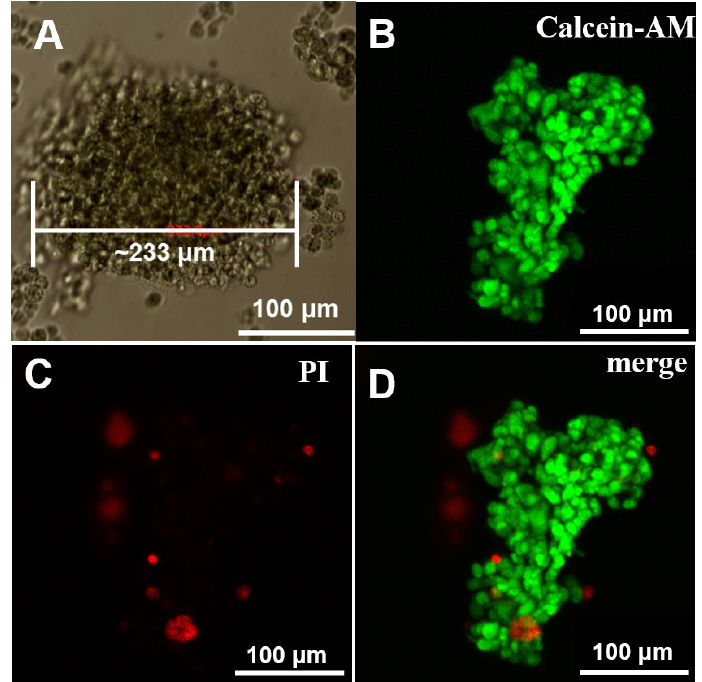
Figure 5. ( A ) photo image and ( B – D ) fluorescence images of C2C12 3D culture in polyaniline doped hydrogel scaffold.